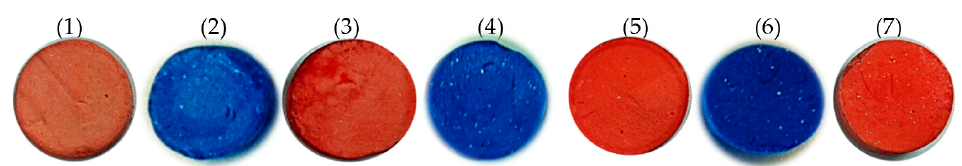
Figure 4. Photograph of cross-section of poly(S/DVB)HIPE modified surface: primary coating contain PDADMAC/PSS; PDADMAC on top of surface ( 1 ), ( 3 ), and ( 5 ); PSS on top of surface ( 2 ), ( 4 ), and ( 6 ) and secondary coating contain TEPA or PEI ( 7 ) as termination coating.